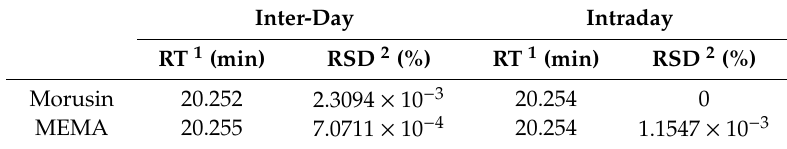
Table 1. Comparison of retention time between MEMA and standard morusin by HPLC analysis.